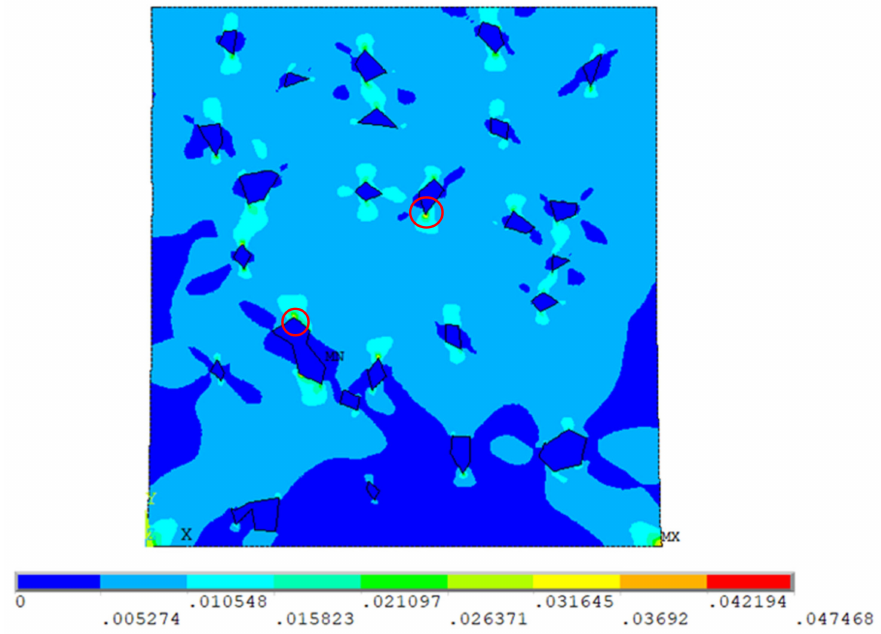
Figure 12. The equivalent plastic strain (%) of RVE 2. The red circles represent strain localization.